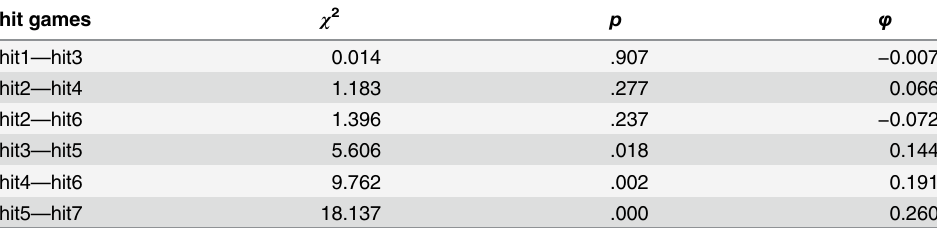
Table 6. Pearson ’ s chi-squared test for